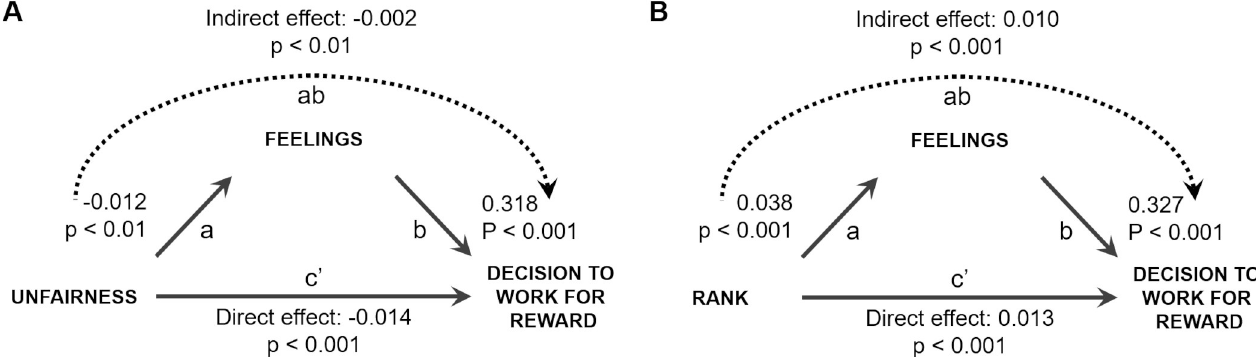
Fig 5. Feelings partially mediate the effect of opportunity gaps on decisions to work for the reward. We examined whether the effect of the two components of the motivational response to opportunity gaps, that is (A) unfairness and (B) rank, were mediated by feelings. In both cases, we controlled for the absolute reward, trial number and either rank (A) or unfairness (B) respectively. In both cases, we found a significant indirect effect and direct effect (which represents the influence of the given factor on decision to work, while controlling for the indirect effect), suggesting that feelings partially mediate the influence of each of the factors on decisions to